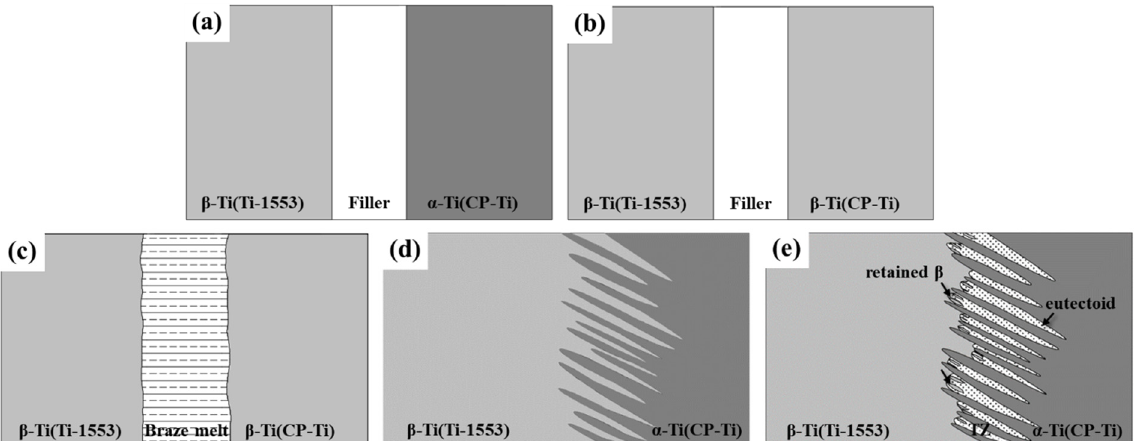
Figure 7. Schematic diagrams of microstructural evolution at different stages of brazing: heating stage, ( a ) RT; ( b ) T β trans < T < T brazing , brazing stage; ( c ) T brazing , cooling stage; ( d ) T eutectoid < T < T β trans ; ( e ) T < T eutectoid .